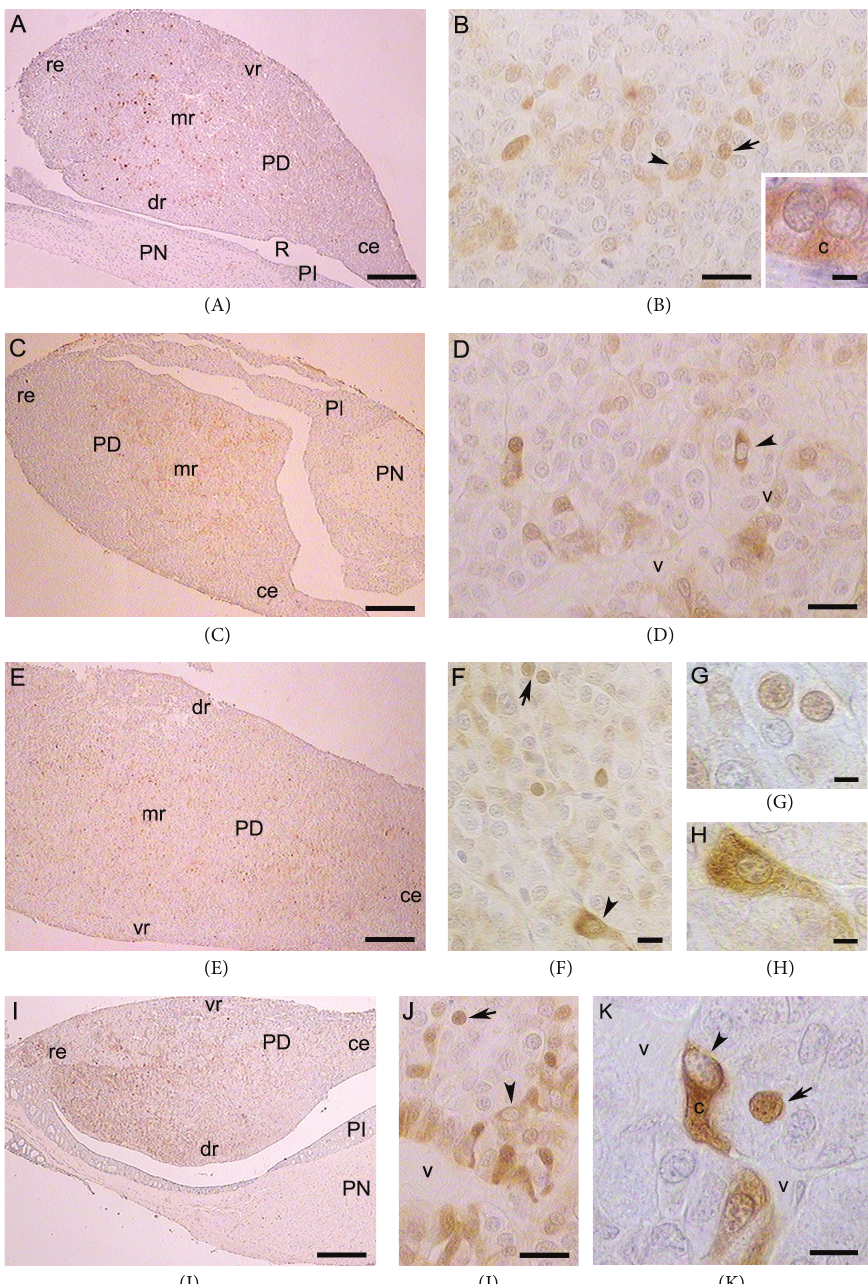
Figure 3: AR immunohistochemical staining of viscacha pituitaries. ((A), (B)) Sections of a fetal pituitary from midpregnancy showing the different zones of PD (A). In the medial region ARn-ir and ARc-ir cells were present (B). Inset: ARc-ir cells (c) with a negative nucleus. ((C), (D)) Images of a fetal pituitary from late pregnancy. Isolated ARc-ir cells around blood vessel (D). ((E), (F), (G), and (H)) AR-ir cells in a pituitary gland of immature viscacha. There are cells throughout the PD (E). The ARn-ir cells are increased in the medial region (F). Magnification of ARn-ir cells (G) and a pituitary cell with heterogeneous cytoplasmic staining (H). ((I), (J), and (K)) Pituitary of a prepubertal viscacha. ARc-ir cells in groups in contact with blood vessel (J) and others with a cytoplasmic prolongation (K). ARn-ir cells (arrows), ARc-ir cells (arrowheads). PD, pars distalis; PI, pars intermedia; PN, pars nervosa; R, Rathke’s pouch; ce, caudal end; re, rostral end; vr, ventral region; mr, medial region; dr, dorsal region; blood vessels, v. ((A), (C), and (I)) Scale bar 500 𝜇 m. (E) Scale bar 250 𝜇 m. ((B), (D), (F), and (J)) Scale bar 25 𝜇 m. Inset of (B), (G), (H), and (K) scale bar 10 𝜇 m. Images counterstaining with